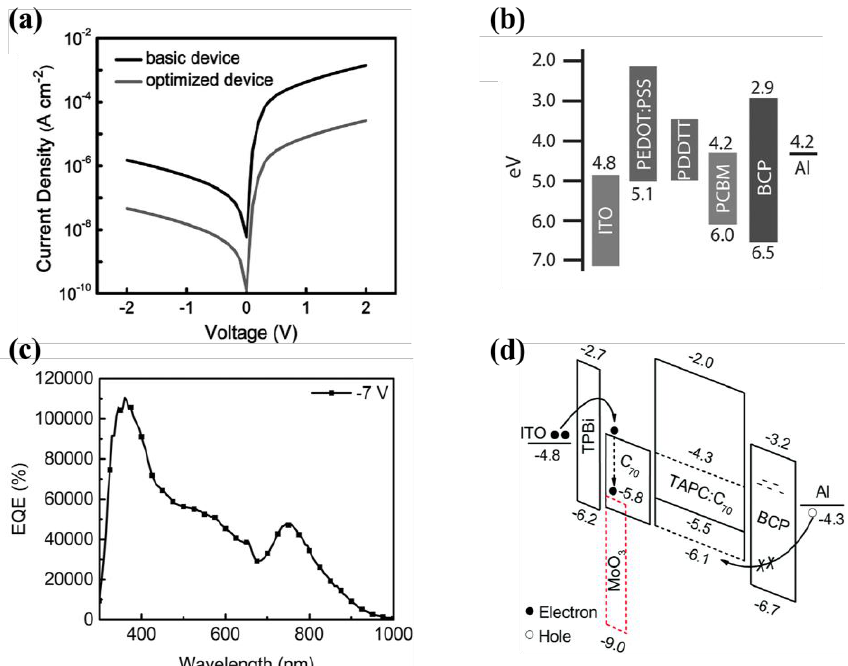
Figure 4. ( a ) Current density-voltage (J–V) characteristics measured in the dark and of the optimized device; ( b ) Schematic energy-level diagrams of the optimized photodetector showing efficient exciton dissociation of the active layer materials and the hole blocking effect of the BCP layer (Reproduced with permission from [44]. WILEY Publishing, 2014). ( c ) Mechanism diagram of the PM-OPDs with the BCP HBLs and MoO 3 electron trapping layer; ( d ) EQE characteristics of the near-infrared response PMOPDs − 7 V bias (Reproduced with permission from [45]. Royal Society of Chemistry Publishing, 2020).